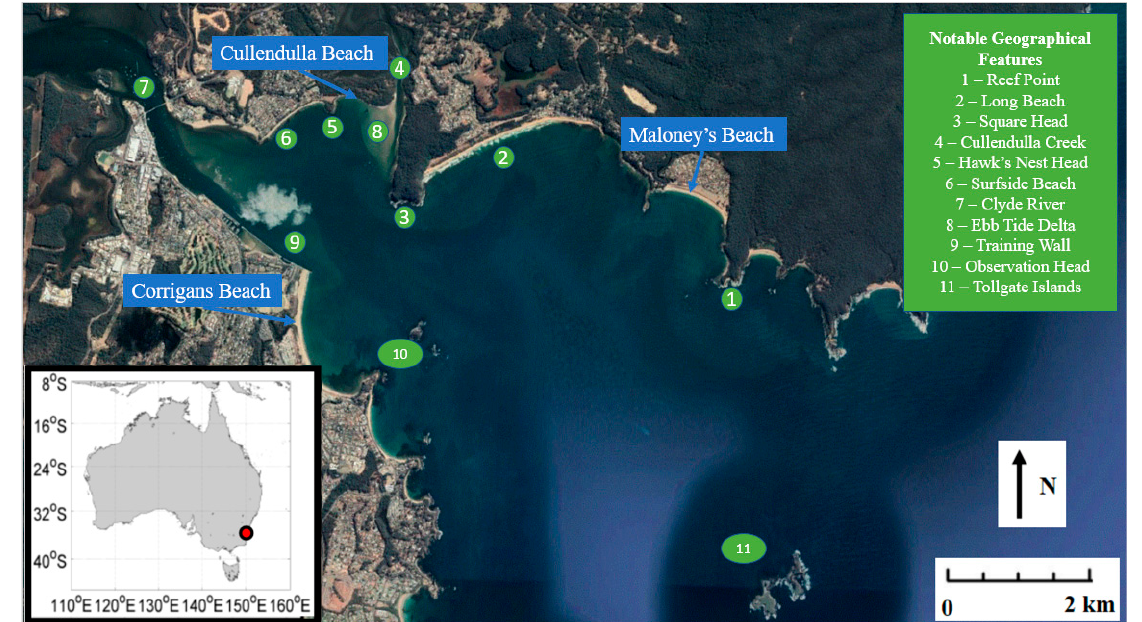
Figure 1. Satellite map of Batemans Bay (35.7144° S, 150.1795° E) with spot markers for site locations and notable geographical features. The inset is a map of Australia with the location of Batemans Bay marked with a red dot (source: Google Earth 2020).